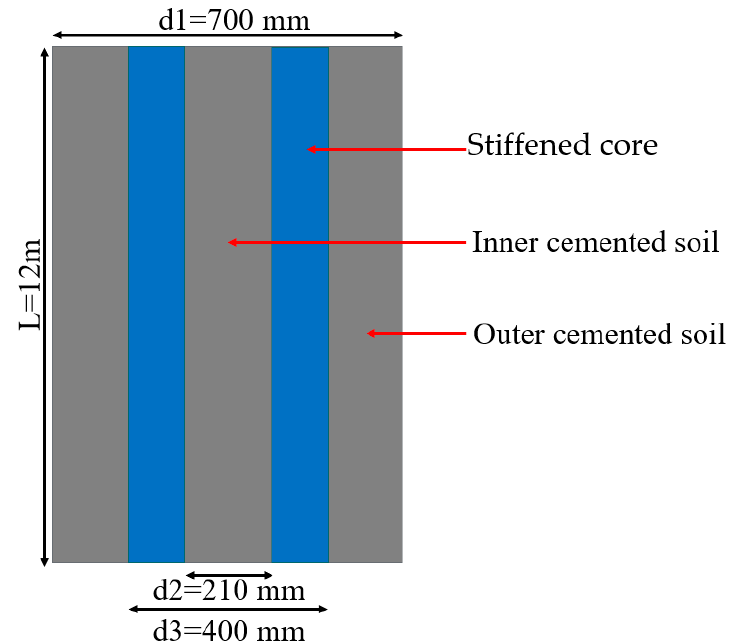
Figure 3. Composition and size of each part of the test pile.